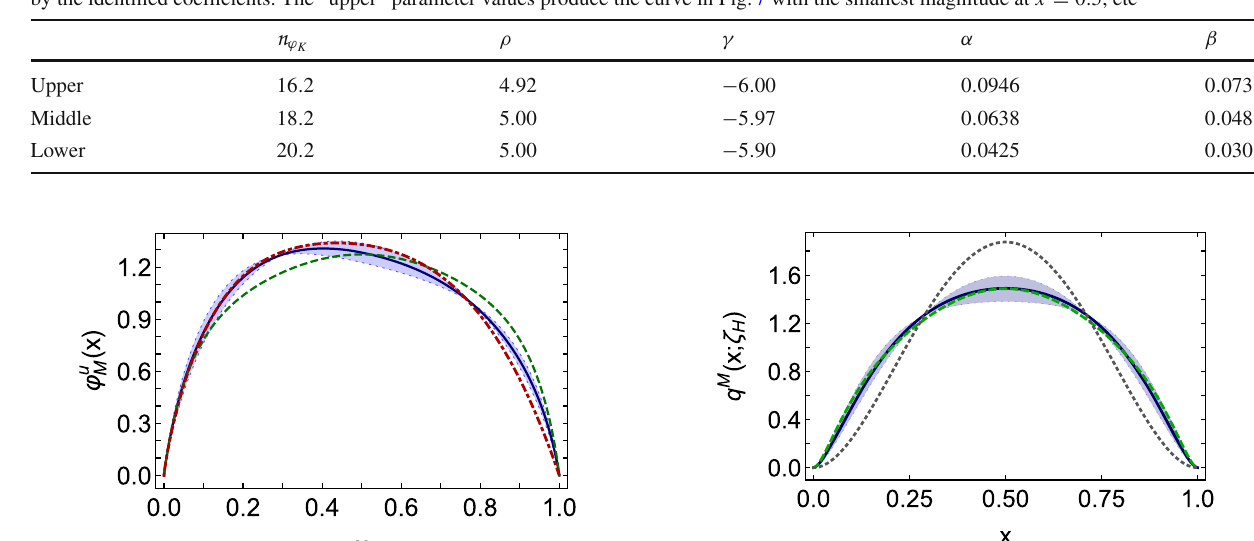
Table 3 Coefficients and powers that specify the kaon DA determined by Eq.(45). Upper, middle, lower refer to the values of (cid:2) ξ 2 (cid:3) by the identified coefficients. The “upper” parameter values produce the curve in Fig.7 with the smallest magnitude at x = 0 . 5, etc